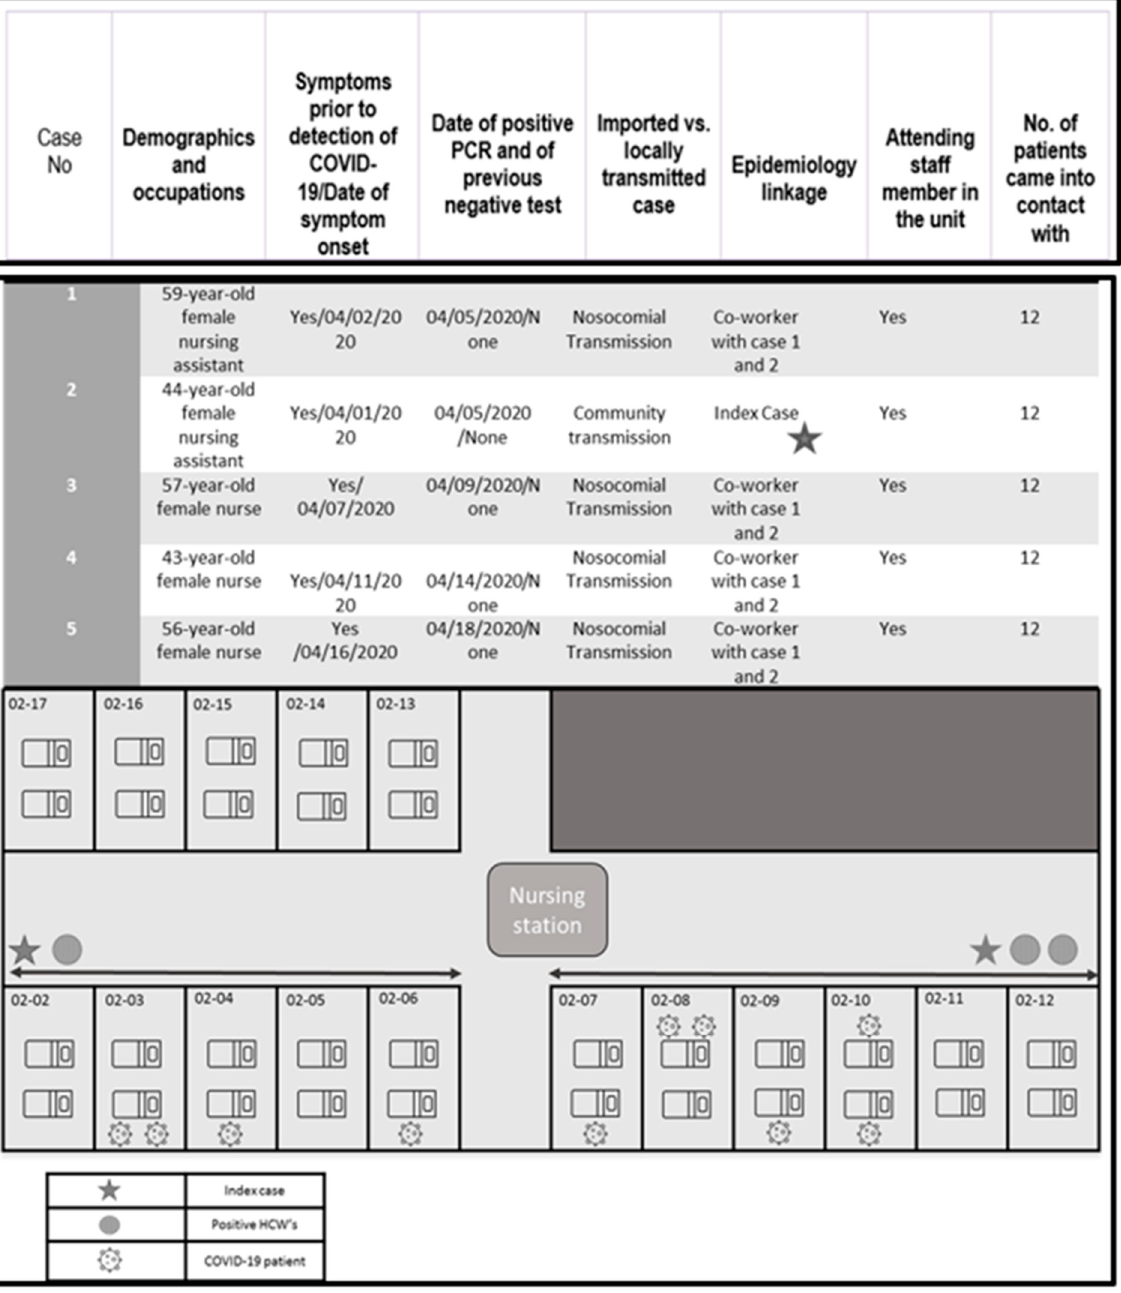
Figure 2. Distribution of HCWs and patients in the unit during the outbreak. Each nursing assistant and nurse had 12 patients under their care. The star shows the index case (nursing assistant). Additional information on the five HCWs with confirmed COVID-19 in the polyvalent ward is given in the box below the figure (demographic details, results of epidemiological investigation, and number of patients exposed).